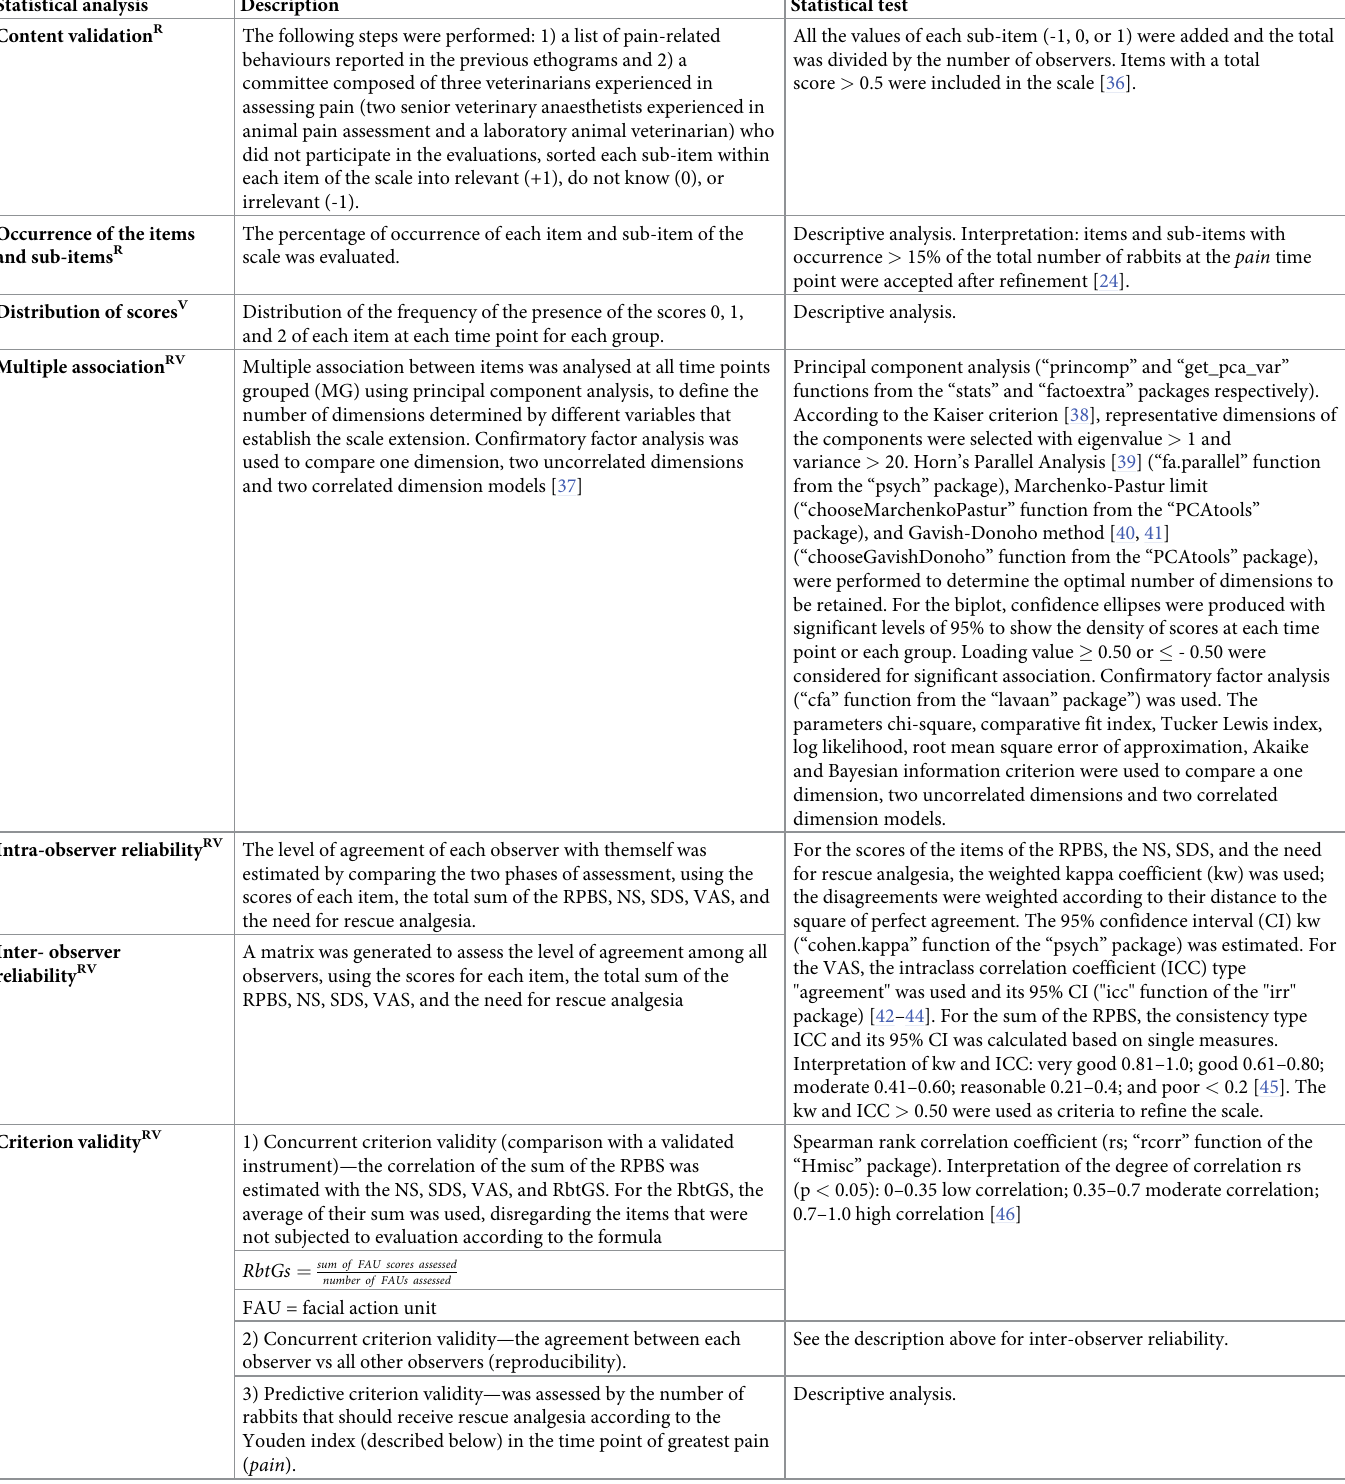
Table 3. Statistical analysis for refinement (R) and validation (V) of the RPBS